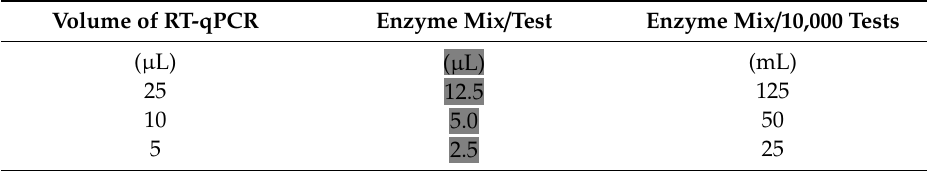
Table 1. Reduction in the amounts of enzyme mix required for RT-qPCR tests by reducing assay volumes. Volume of